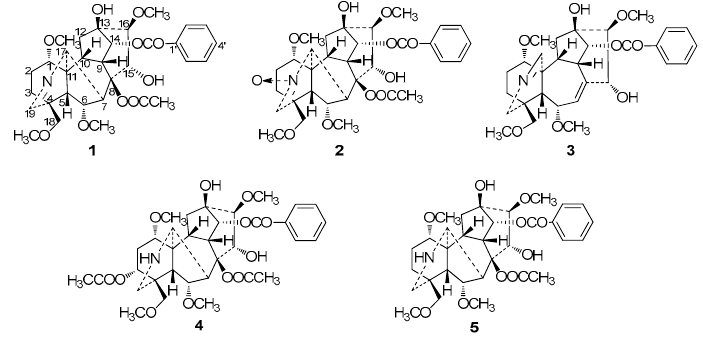
Figure 1. Structures of compounds 1 – 5 .